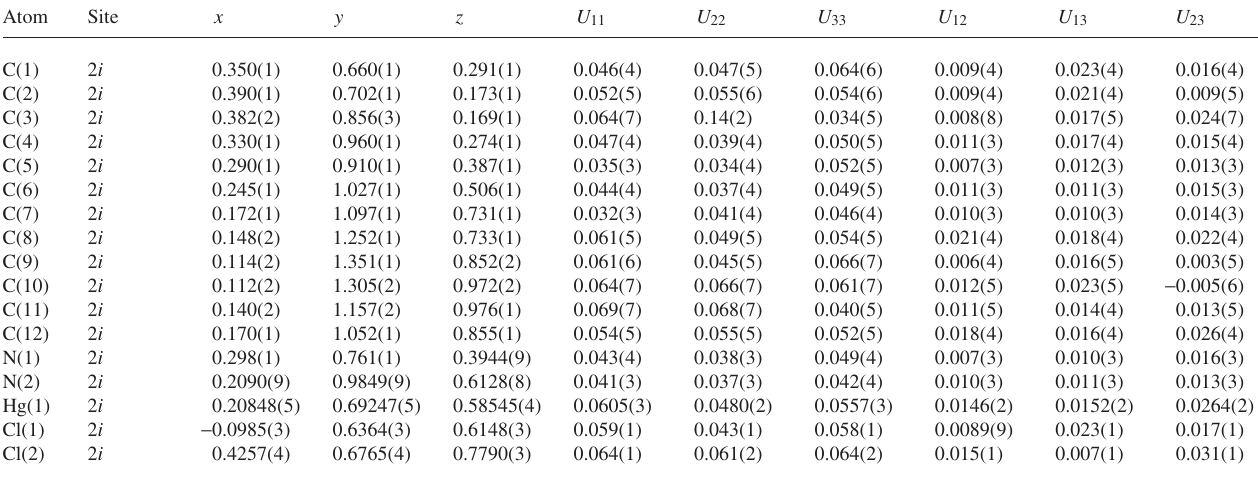
Table 3. Atomic coordinates and displacement parameters (in Å 2 ) .